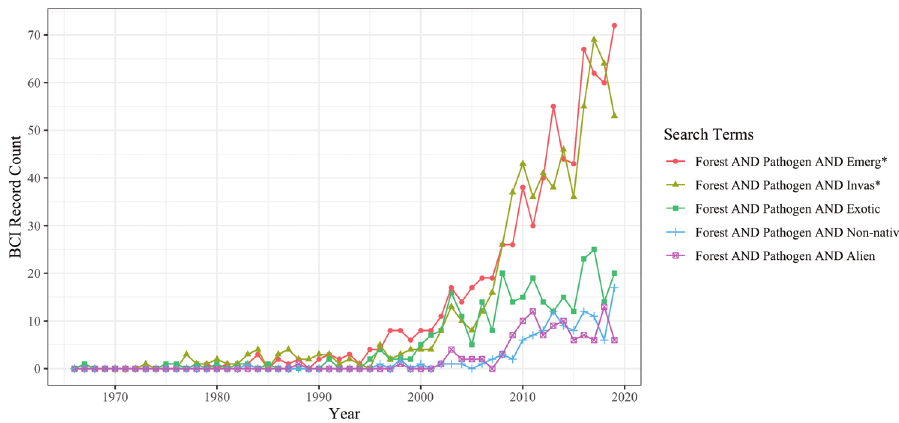
Figure 1. Number of record counts returned from a Web of Science search including the terms “forest” and “pathogen” together with the terms “invas*”, “emerg*”, “alien”, “exotic” and “non-native”, for the years